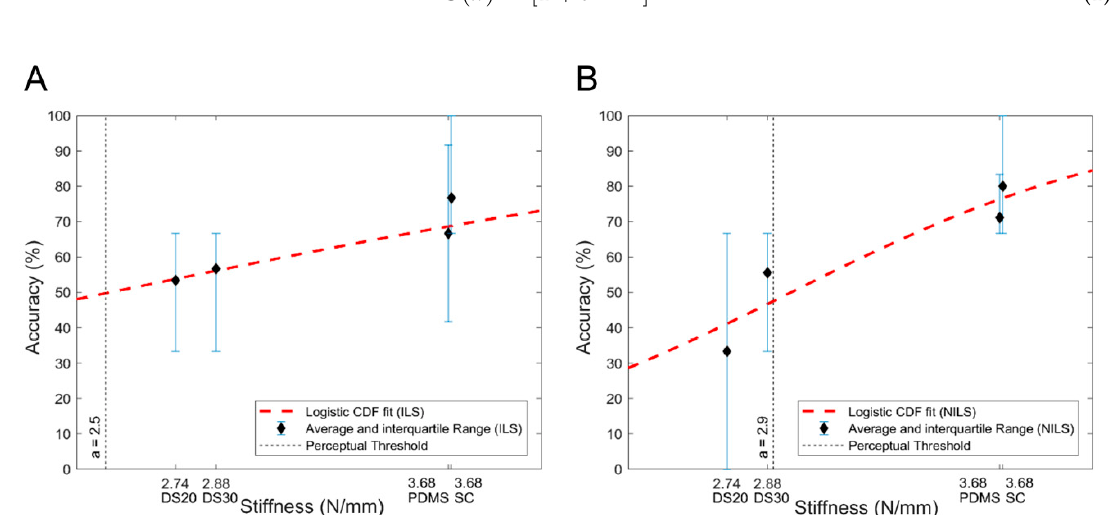
Figure 7. Psychometric curves for the psychophysical experiments: ( A ) ILS telepresence condition; ( B ) NILS telepresence condition. Black diamonds show the identification rate for all the encapsulated materials (average across participants); error bars are the interquartile range across participants; red dashed lines represent the logistic cumulative distribution function (CDF) fit.